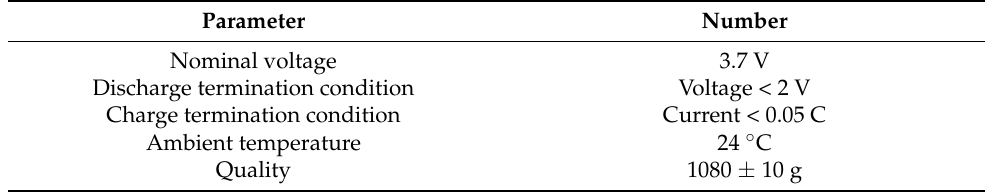
Table 1. Lithium battery experimental